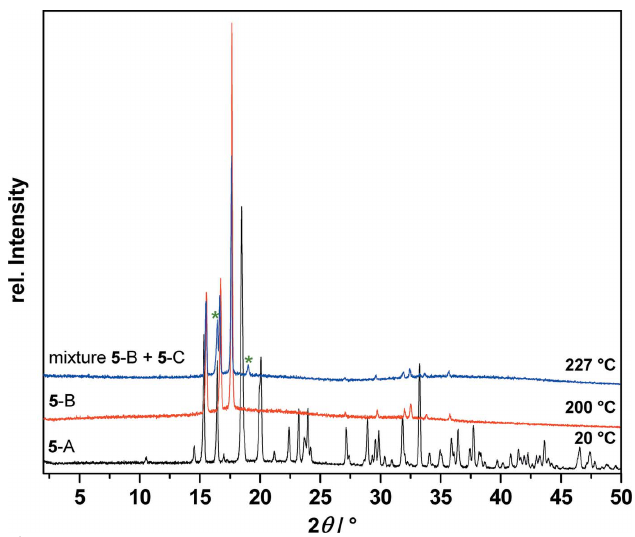
Figure 8 Temperature-dependent X-ray powder diffraction traces of cis -inositol ( 5 ) at 20, 200 and up to 227 (cid:2) C showing the phase transition of polymorph 5 -A (black) to the first high-temperature polymorph 5 -B (red) to the second high-temperature polymorph 5 -C (blue). The asterisks (green) denote new reflections caused by polymorph 5 -C.